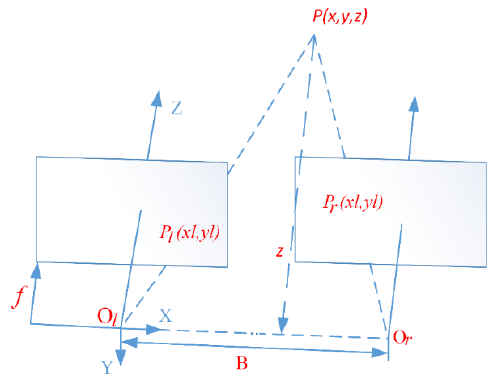
10 of 21 Figure 7. Flow chart of monocular camera lane change judgment.